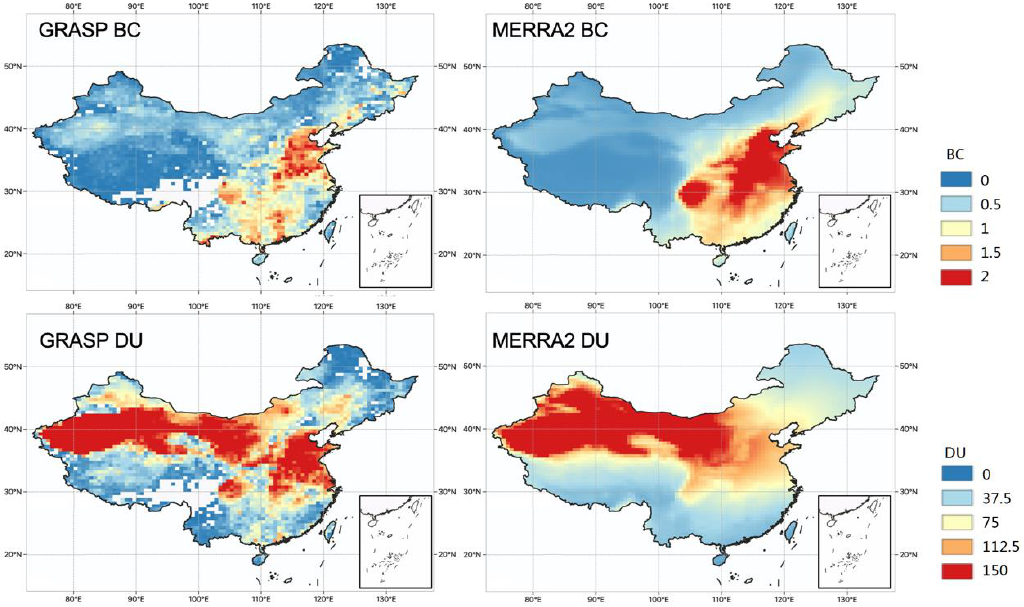
Figure 15. Spatial distribution of 2011–2013 climatological BC and DU columnar concentrations from PARASOL/GRASP and MERRA-2. The PARASOL/GRASP data is resampled to MERRA-2 0.625 × 0.5° resolution.